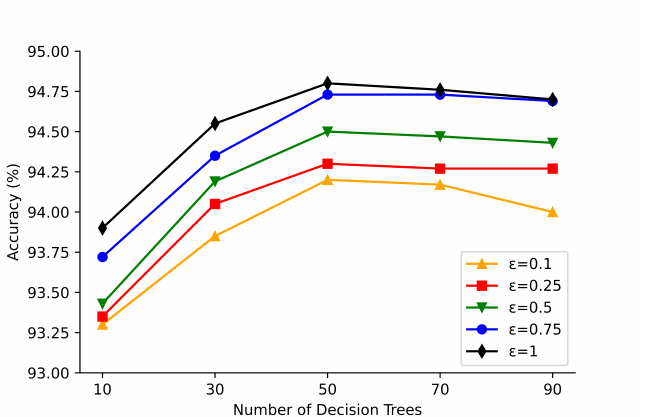
Figure 5. Variation of classification accuracy with the number of decision trees for Mushroom dataset.